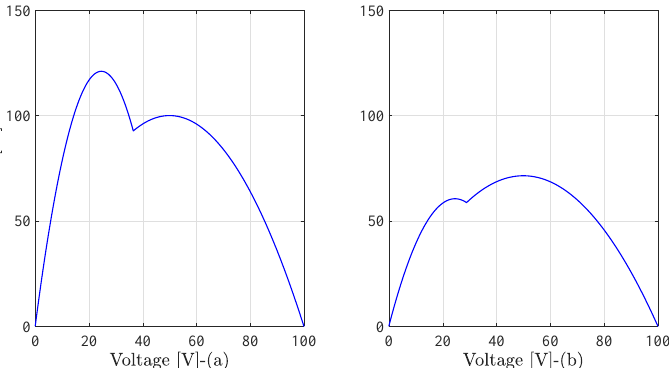
Figure 5. The characteristics of the PV emulator to represent partial shading conditions: ( a ) The global peak is on the left side ( b ) The global peak is on the right